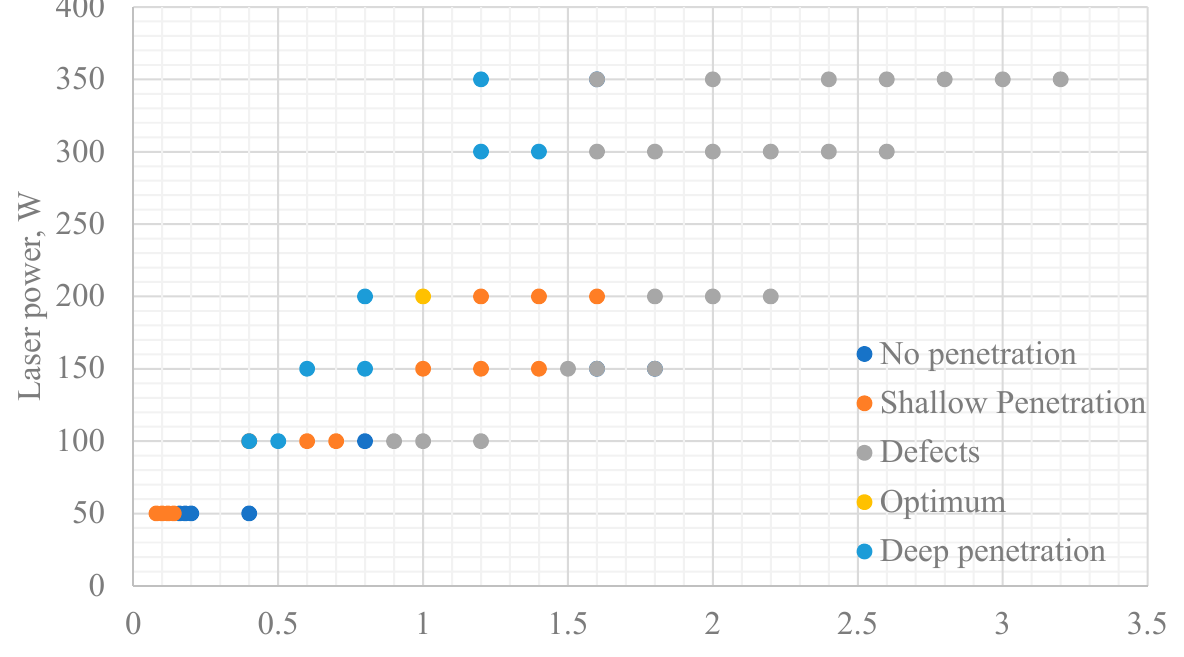
Figure 4. Classification of the laser penetration profiles.